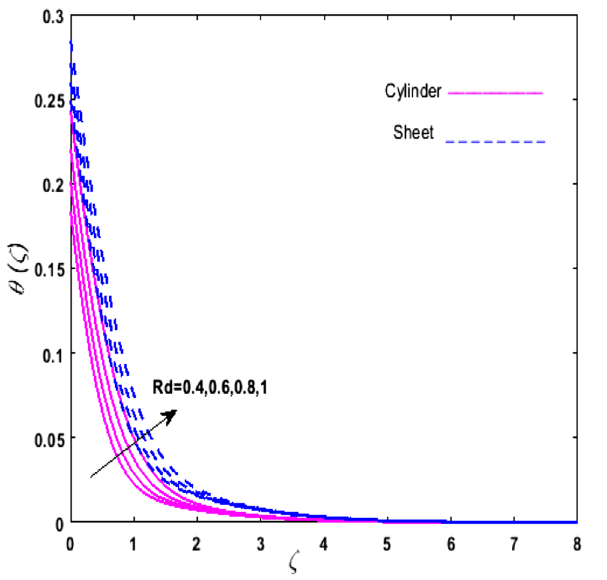
Figure 10. Upshot of Rd on θ(ζ)